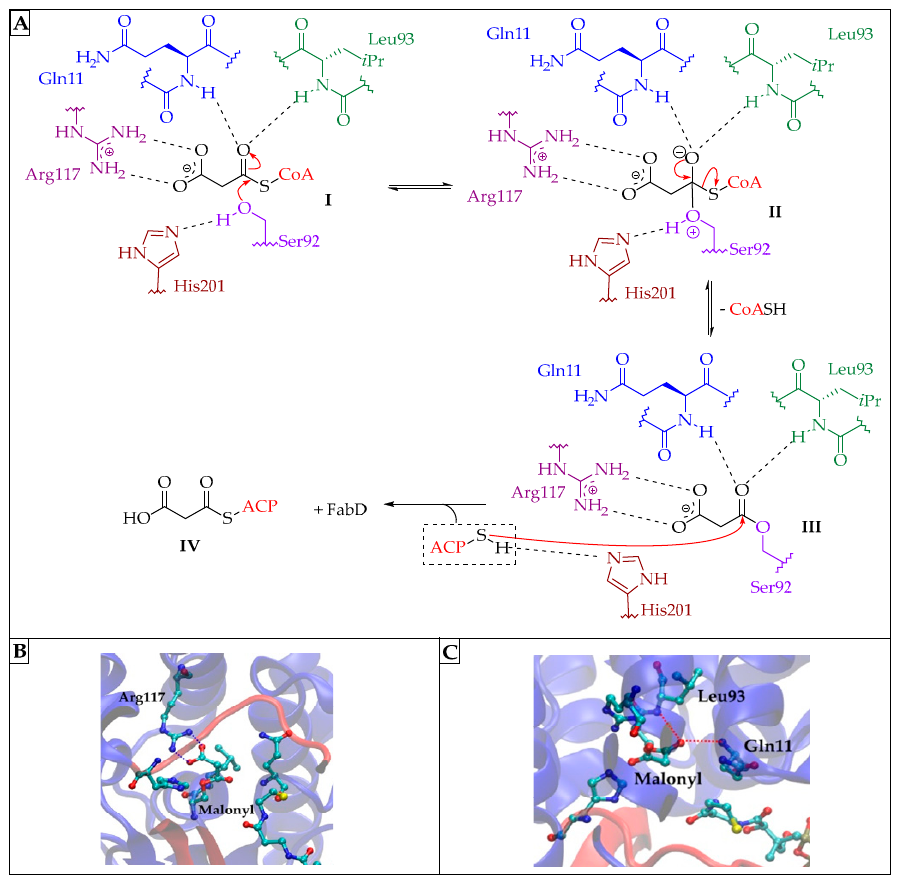
Figure 3. ( A ) Scheme of the mechanism of the transfer of malonyl moiety from malonyl-CoA to ACP catalysed by FabD in E. coli . ( B , C ) Views of the active site of Ec FabD in which malonyl-CoA was crystallized (PDB ID 2G2Z). They highlight ( B ) the bidentate salt bridge (blue dots) between the carboxylate moiety of the malonate and the guanidinium group of the Arg117 and ( C ) hydrogen bonds between the carbonyl of malonate covalently bound to Ser92 and the main-chain amides of Gln11 and Leu93 which form the oxyanion hole (red